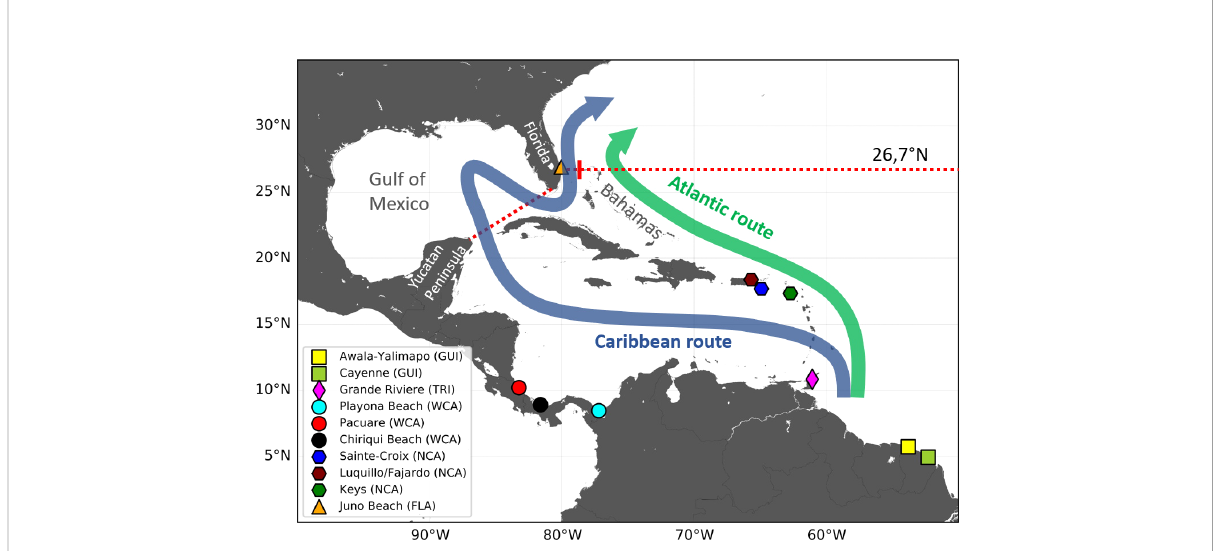
FIGURE 3 Schematic map of the Atlantic and Caribbean routes featuring all nesting beaches from which juvenile dispersal is simulated. The two dotted red lines are the 26.7°N parallel (used as the fi nish line of the Caribbean and Atlantic routes) and the Yucatan-to-Florida straight line [used to determine entrance into the Gulf of Mexico (GoM)].